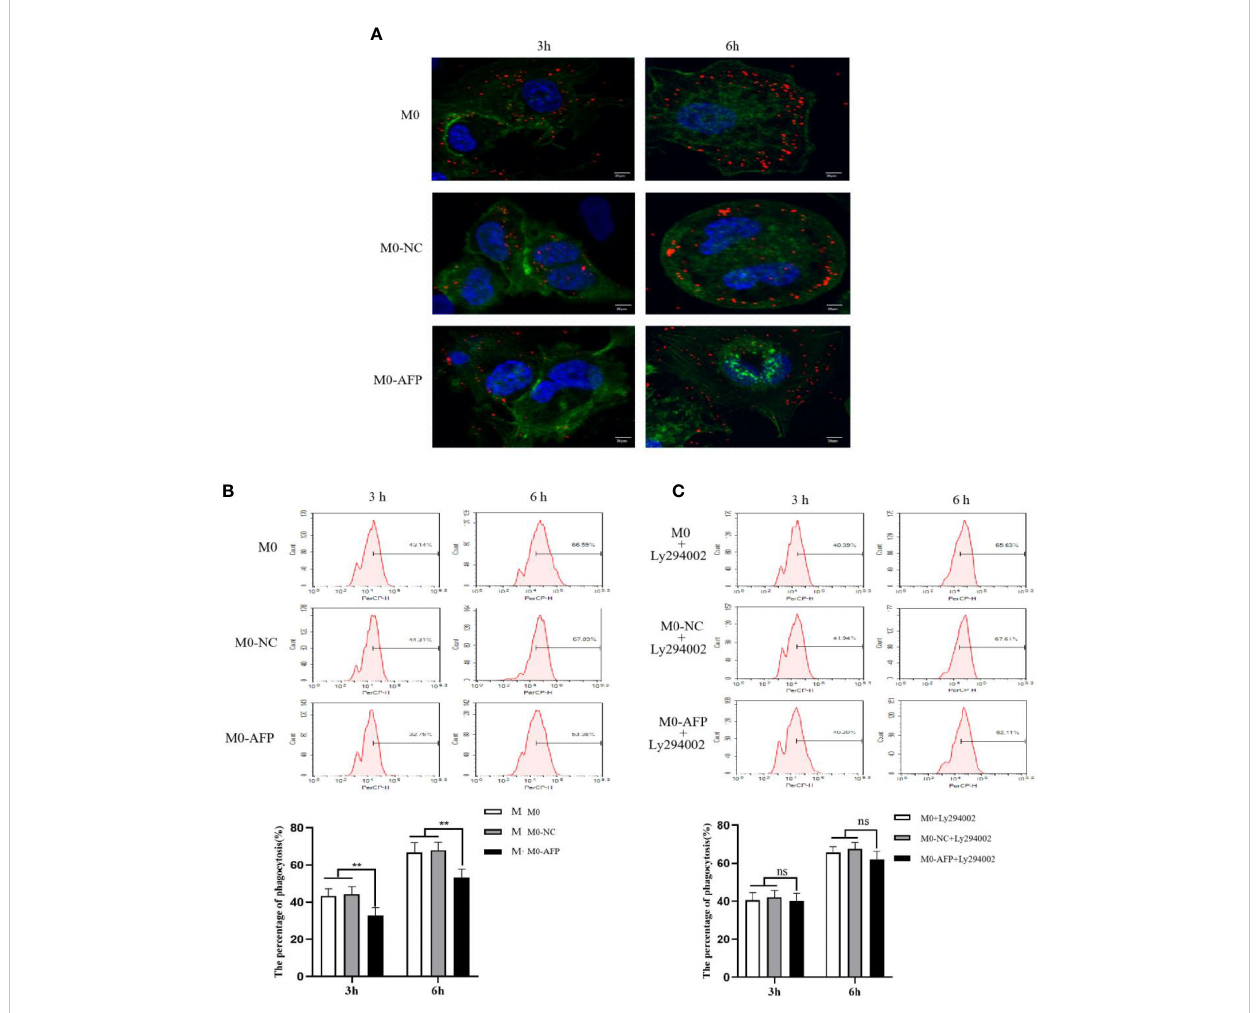
FIGURE 5 The effects of AFP and Ly294002 (PI3K inhibitor) on macrophages enggul fi ng polystyrene latex beads. M0 macrophages were infected with an AFP- expressing negative control lentivirus vector(M0-NC) or AFP-expressing lentivirus vector(M0-AFP) for 48 h and then treated with LPS+IFN- g for 24 h to induce M0 macrophage polarization into M1-like phenotype. (A) Macrophages engulfed polystyrene latex beads in the M0, M0-NC and M0-AFP groups at 3 h and 6 h were observed by laser confocal microscopy; the fl uorescence intensity represents the numbers of phagocytoses. Blue: cell nucleus(DAPI stained); Green: cytoplasm(5-(and -6)-carboxy fl uorescein diacetate succinimidyl ester(CFSE) incorporation of the intracellular fl uorescent dye); Red: polystyrene latex beads. (B) Macrophages engulfed the numbers of polystyrene latex beads in the M0, M0-NC and M0 AFP groups at 3 h and 6 h, detected by fl ow cytometry; the lower column diagram shows the statistical analysis of the phagocytosis rate of each group, ** P <0.01. (C) After treatment with the PI3K inhibitor Ly294002 for 24 h, macrophages engulfed the numbers of polystyrene latex beads in the M0, M0-NC and M0-AFP groups at 3 and 6 h were detected by fl ow cytometry; the low column diagram shows the statistical analysis of the phagocytosis rate of each group, P >0.05. The images are from the at least three independent